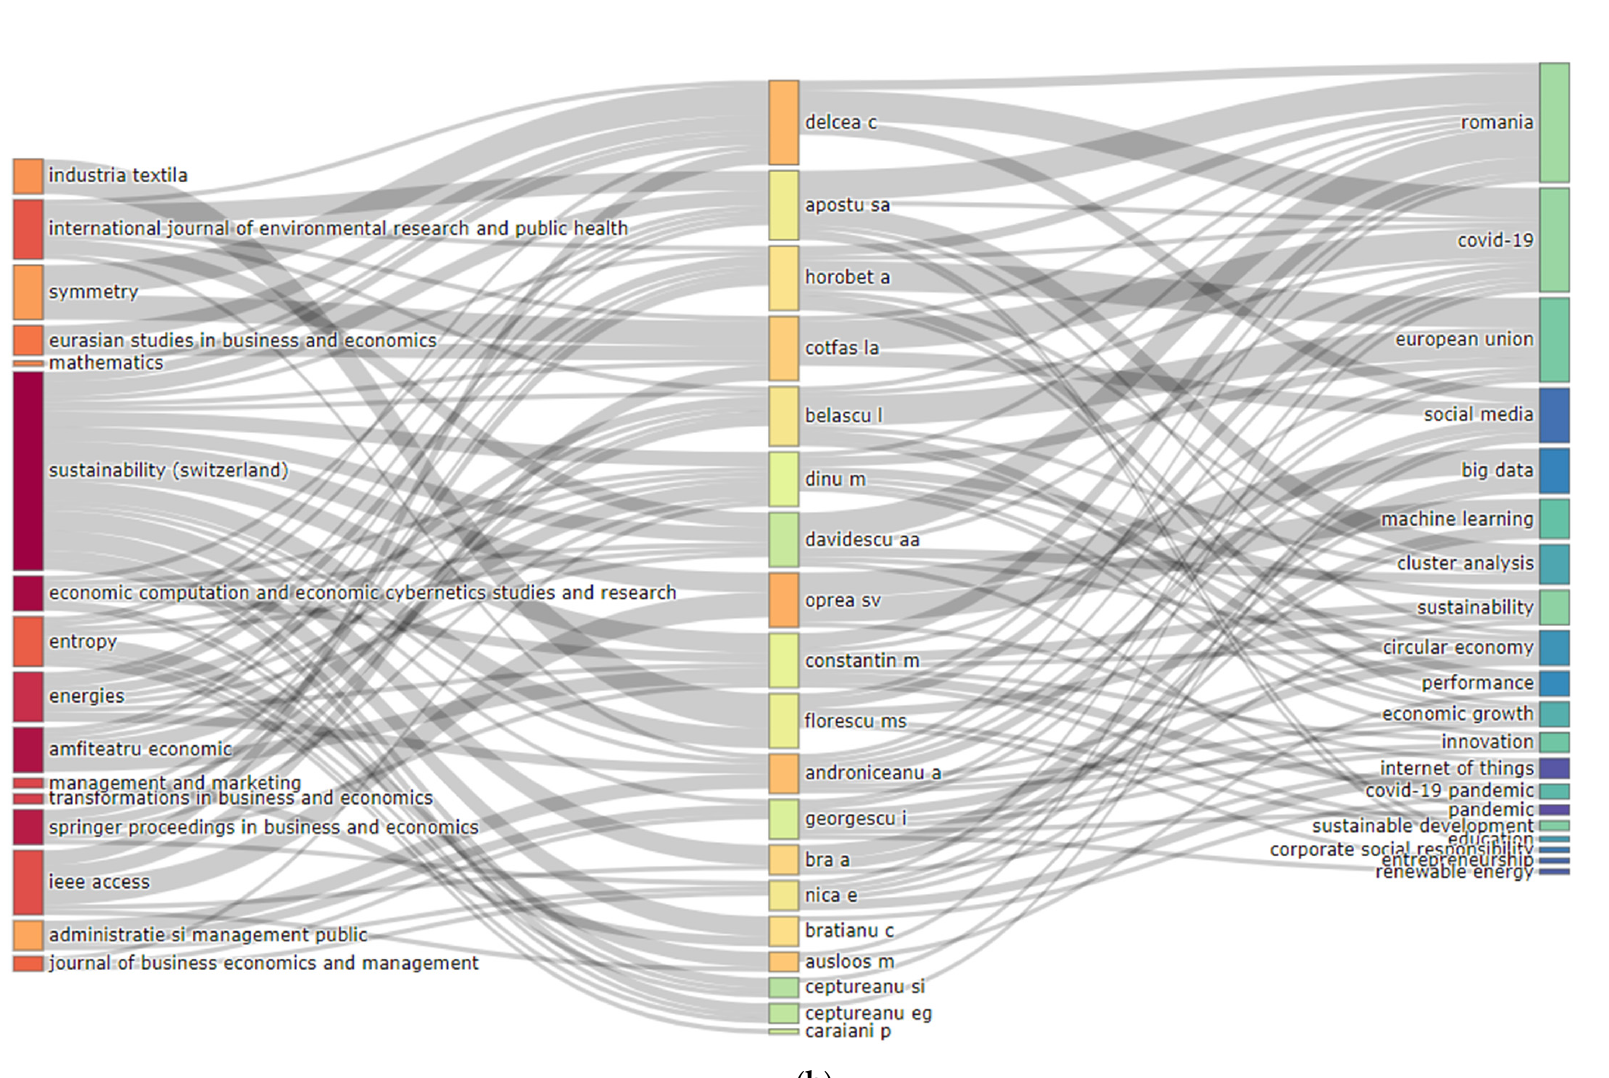
Figure 7. Three field plots. ( a ) WoS. ( b ) Scopus.